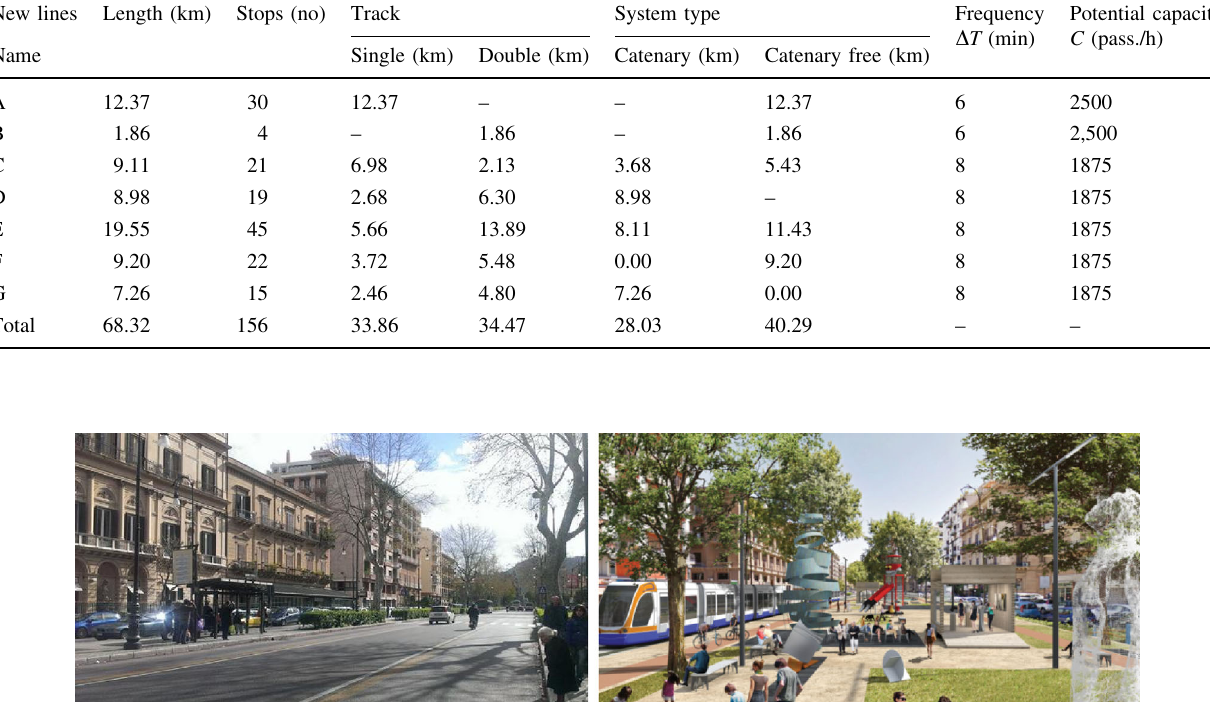
Table 6 Main characteristics of the seven new tramway lines New lines